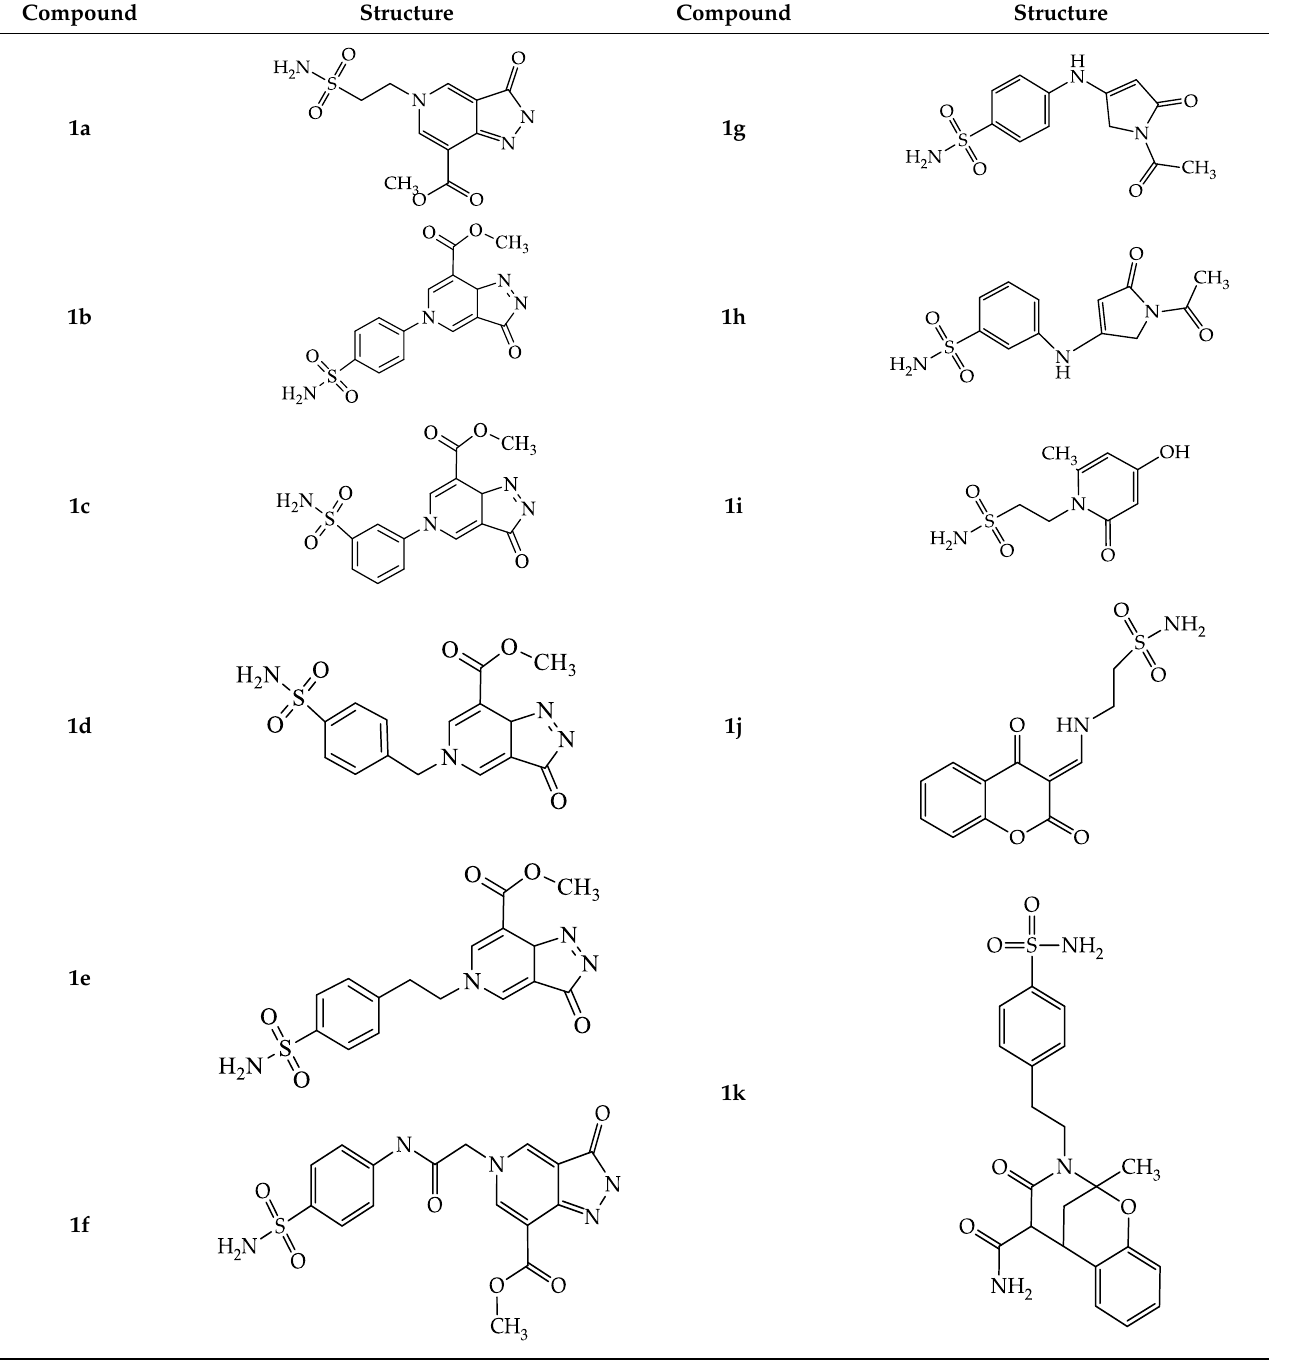
Table 2. Inhibition data of human CA isoforms I, II, IX, and XII with labeled compounds and AAZ by a stopped-flow CO 2 hydrase assay.